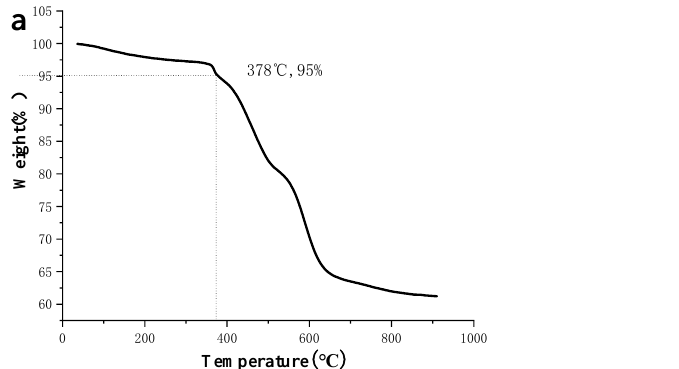
Figure 5. TGA profiles of ( a ) CMP − shu − 1, ( b ) CMP − shu − 2.